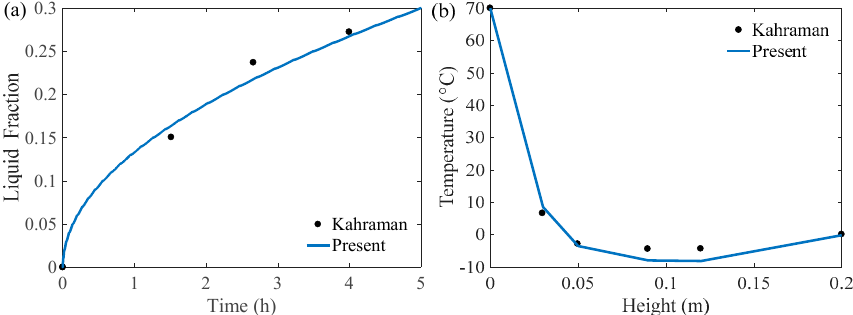
Figure 6. Validation of the present numerical model with the experimental data reported by Kahraman [37]. ( a ) Liquid fraction; (b ) temperature profile of centerline ( x = 0.1 m, 0 ≤ y ≤ 0.2 m) at time = 1.7 h.